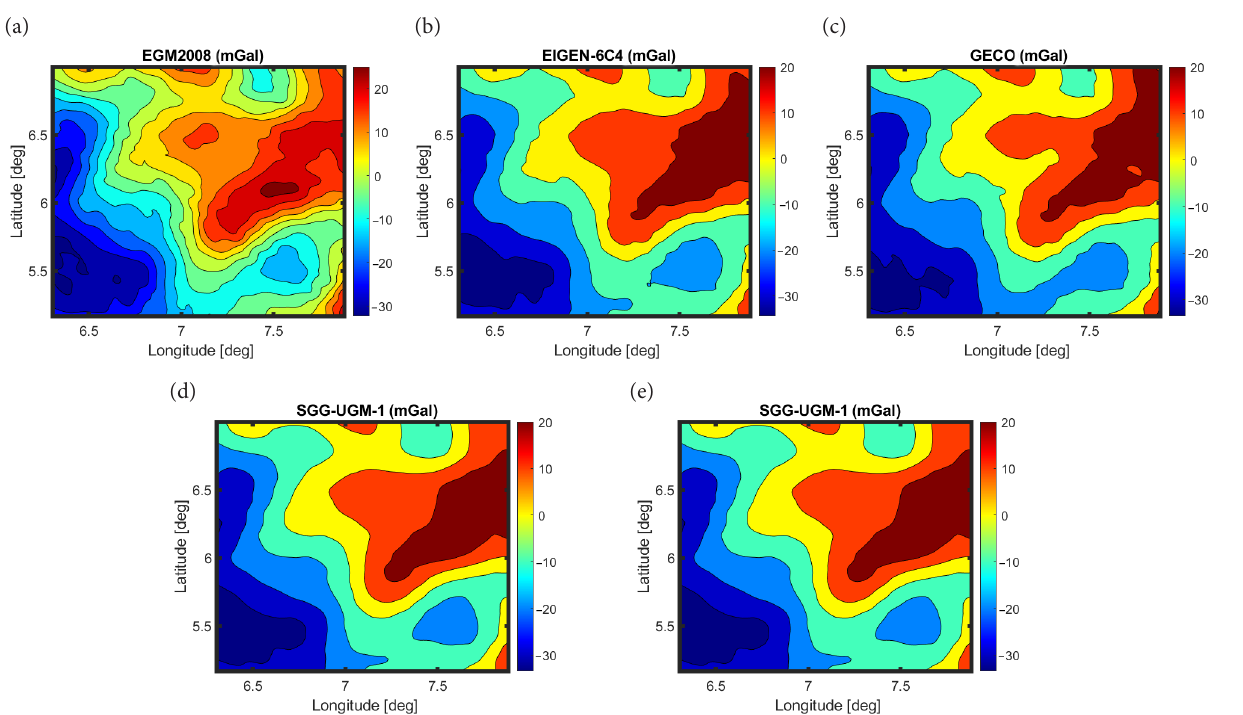
Figure 13. Geological versus tailored GGM-derived Bouguer gravity map of the Anambra